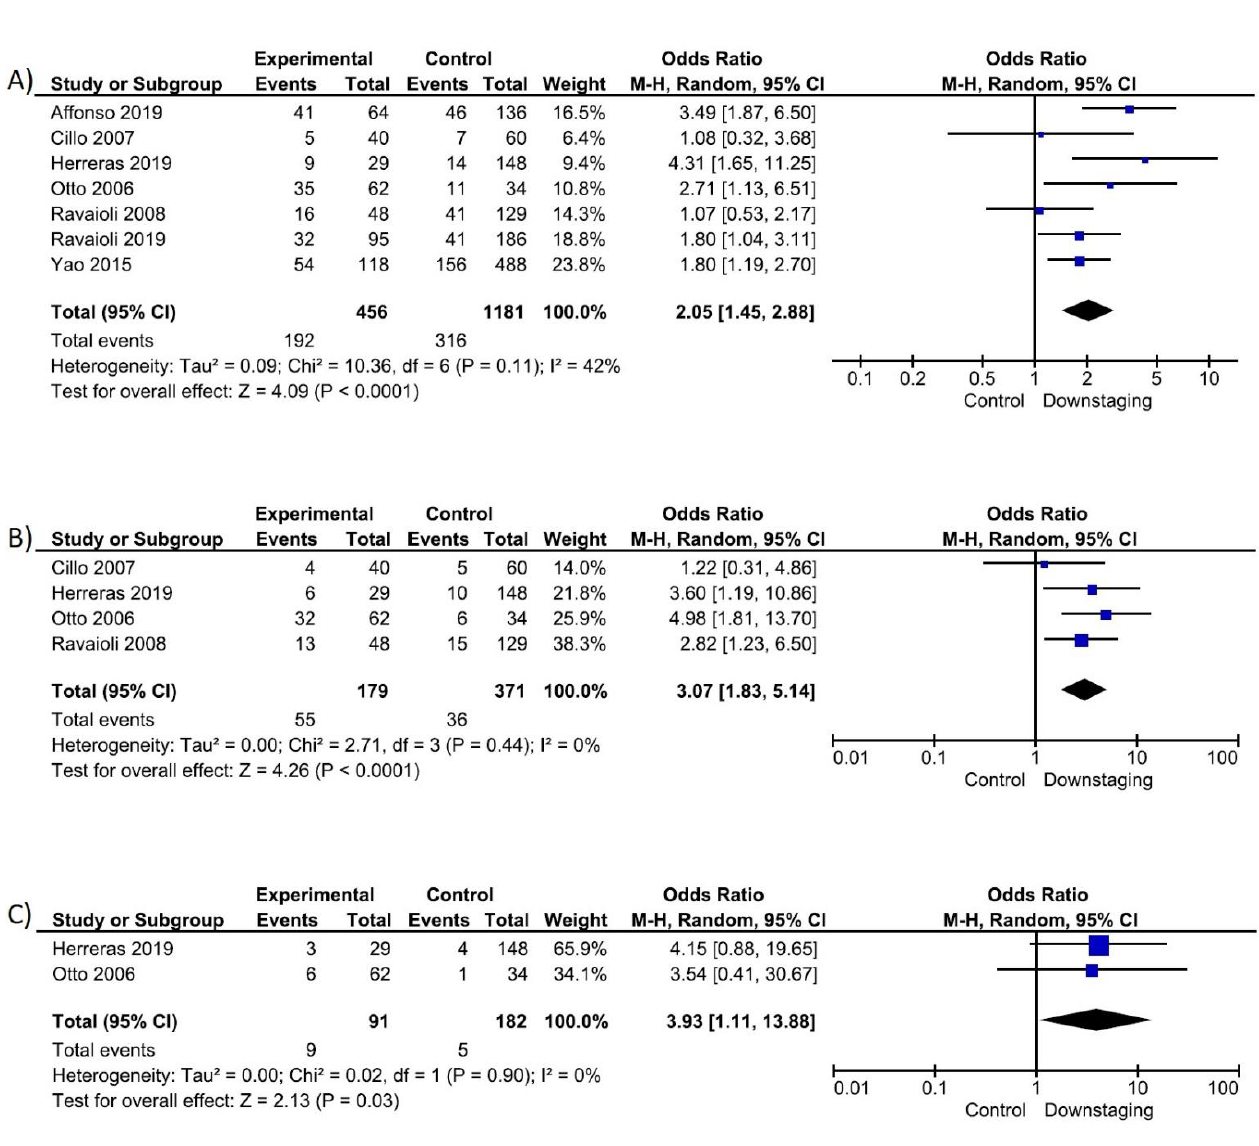
Figure 2. Question 1: Forrest plot on drop-out rate: ( A ) Drop-out due to all causes; ( B ) Drop-out due to tumour progression; ( C ) Drop-out due to liver deterioration.